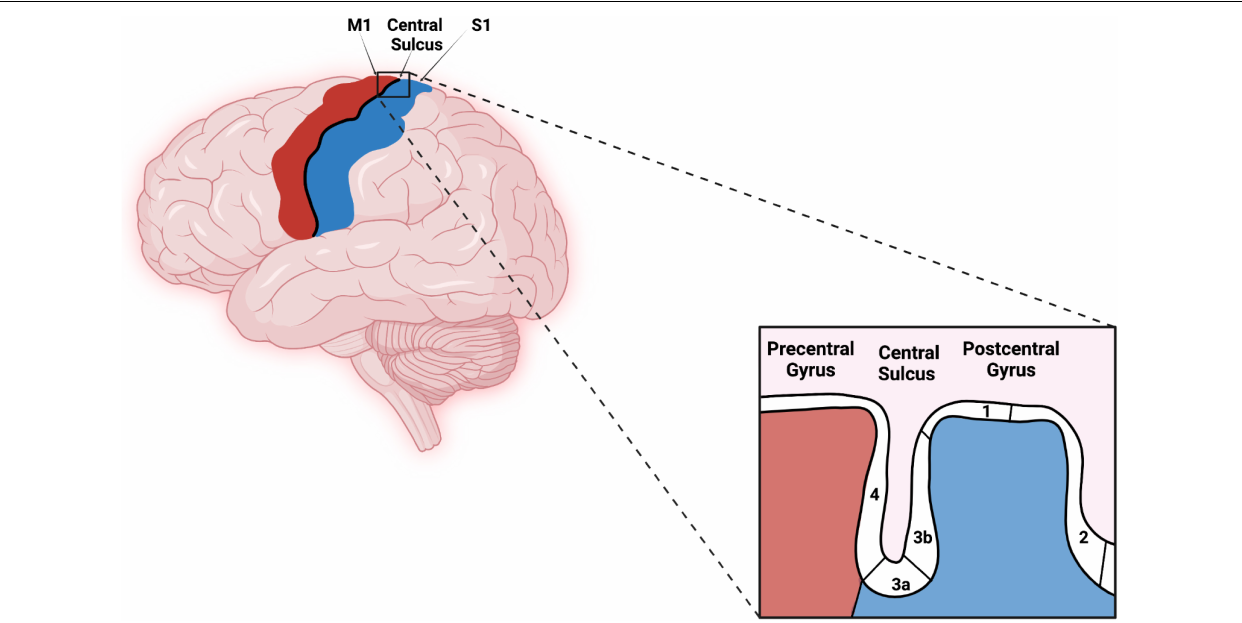
FIGURE 1 | Original work showing lateral view of the primary motor cortex, central sulcus (CS), primary somatosensory cortex, and corresponding Brodmann areas (BAs) (4, 3a, 3b, 1, and 2). Red–Primary motor cortex, Blues–Primary somatosensory cortex. The figure was created using Biorender.com.